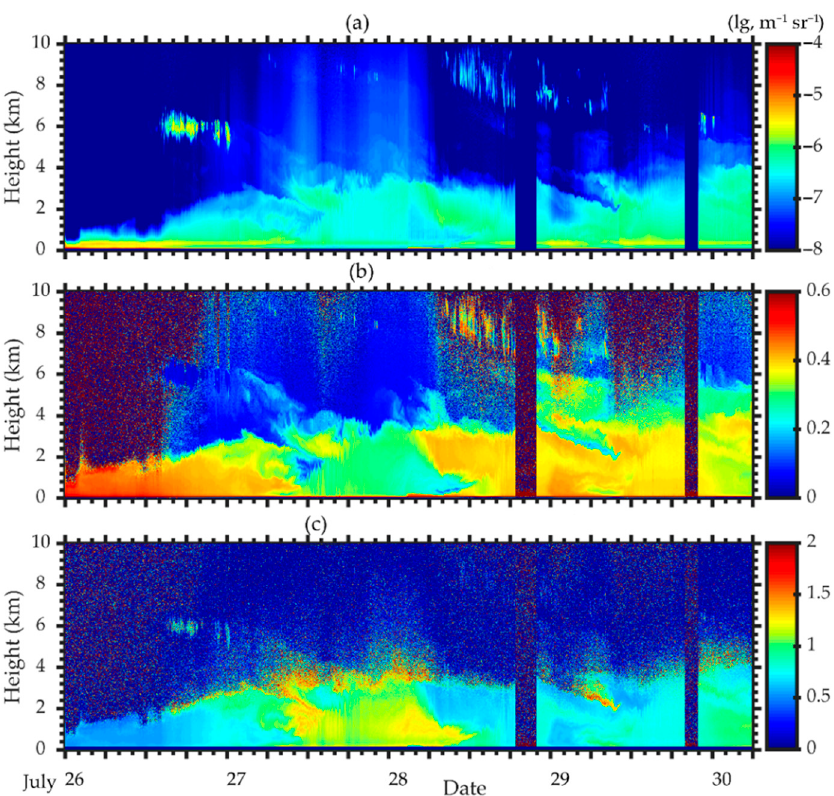
Figure 5. An overview of ( a ) TABC 532 (lg, m − 1 sr − 1 ), ( b ) VDR 532 , and ( c ) δ 532, 355 = VDR 532 / VDR 355 on 26–30 July 2019.